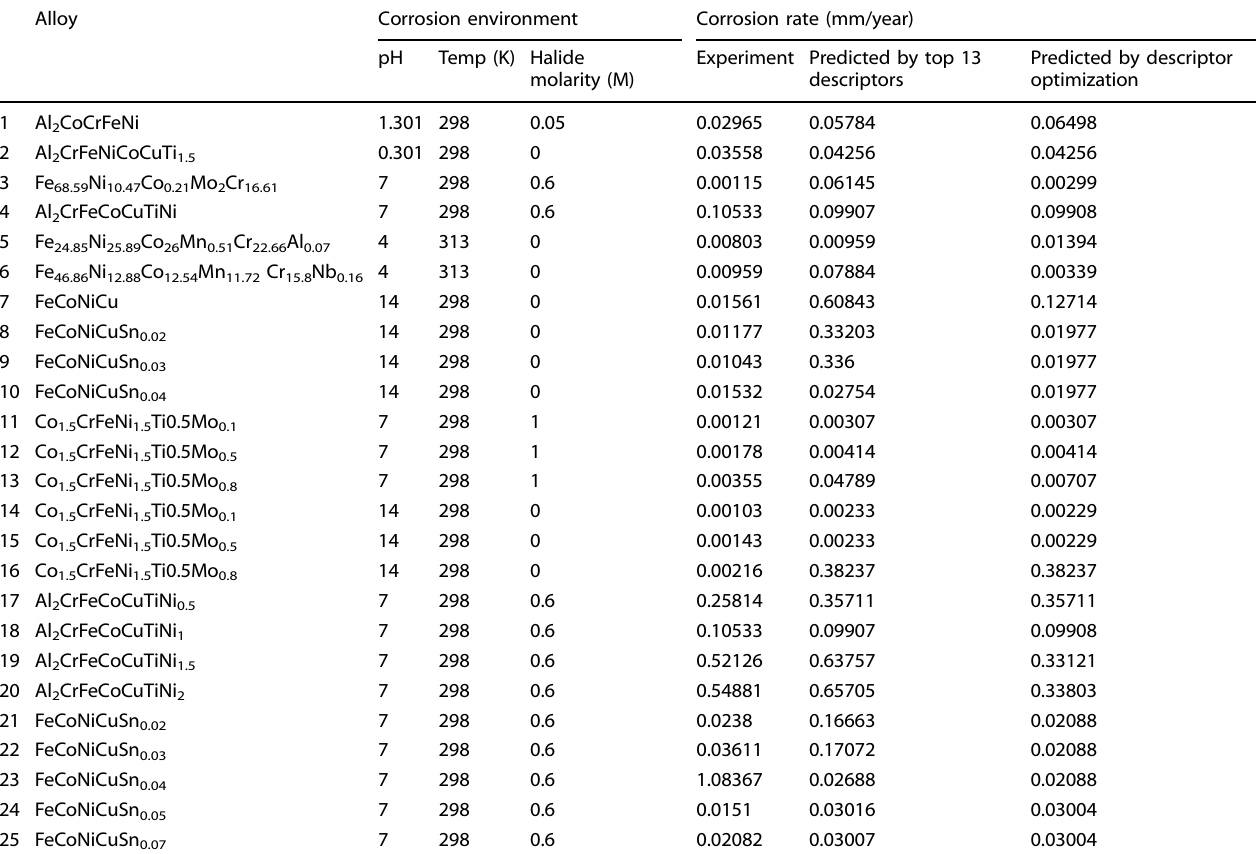
Fig. 2 The relative importance of the top 13 features to predict the corrosion rate. This down selected pool will be subsequently used for stage 2 feature down selection. The second stage may result in a reshuf fl ing of the rankings of the top features. Table 1. Validation dataset with details of the corrosive environment, corresponding observed experimental corrosion rate 8,9 and predicted corrosion rate by considering the top 13 descriptors and the optimized